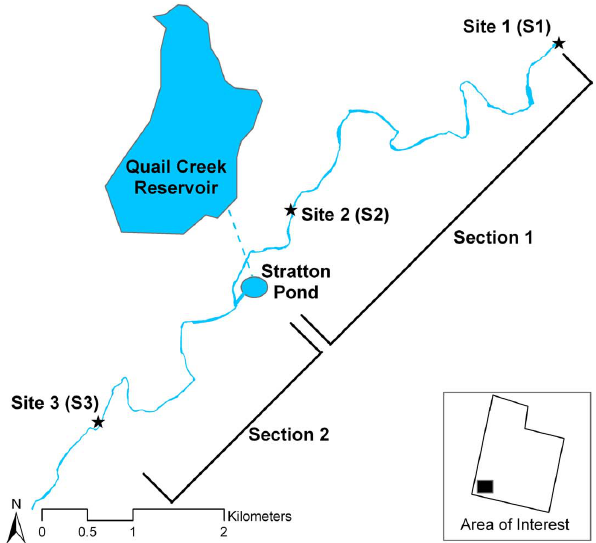
Fig. 1. Study reach layout including data collection locations. In- set map shows the state of Utah, USA, with the study area shown highlighted in black. (Taken directly from Bingham, 2010).